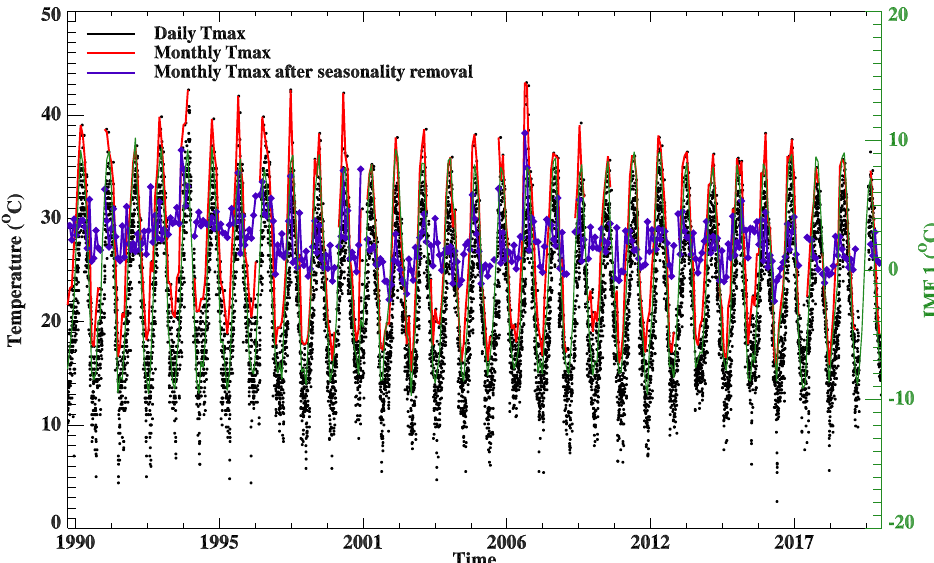
Figure 2. Maximum daily temperature recorded at the Crotone station (black dots), evolution of monthly maximum temperatures before (red line) and after (purple line) subtracting the seasonal mode obtained with the EMD decomposition. The right y-axis shows the IMF 1 amplitude (green